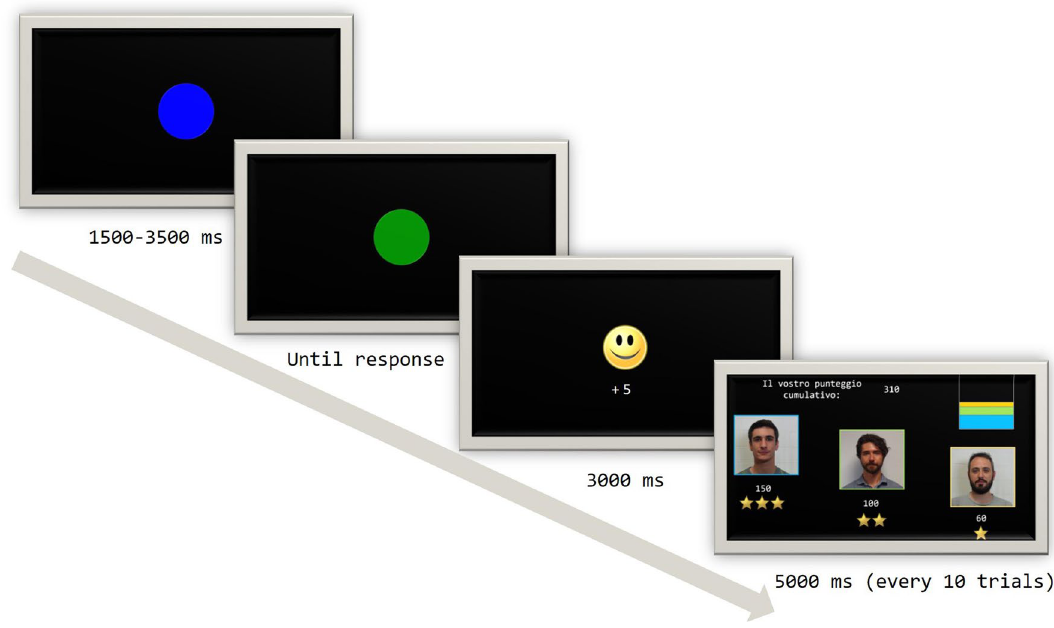
Figure 1. Status-inducing